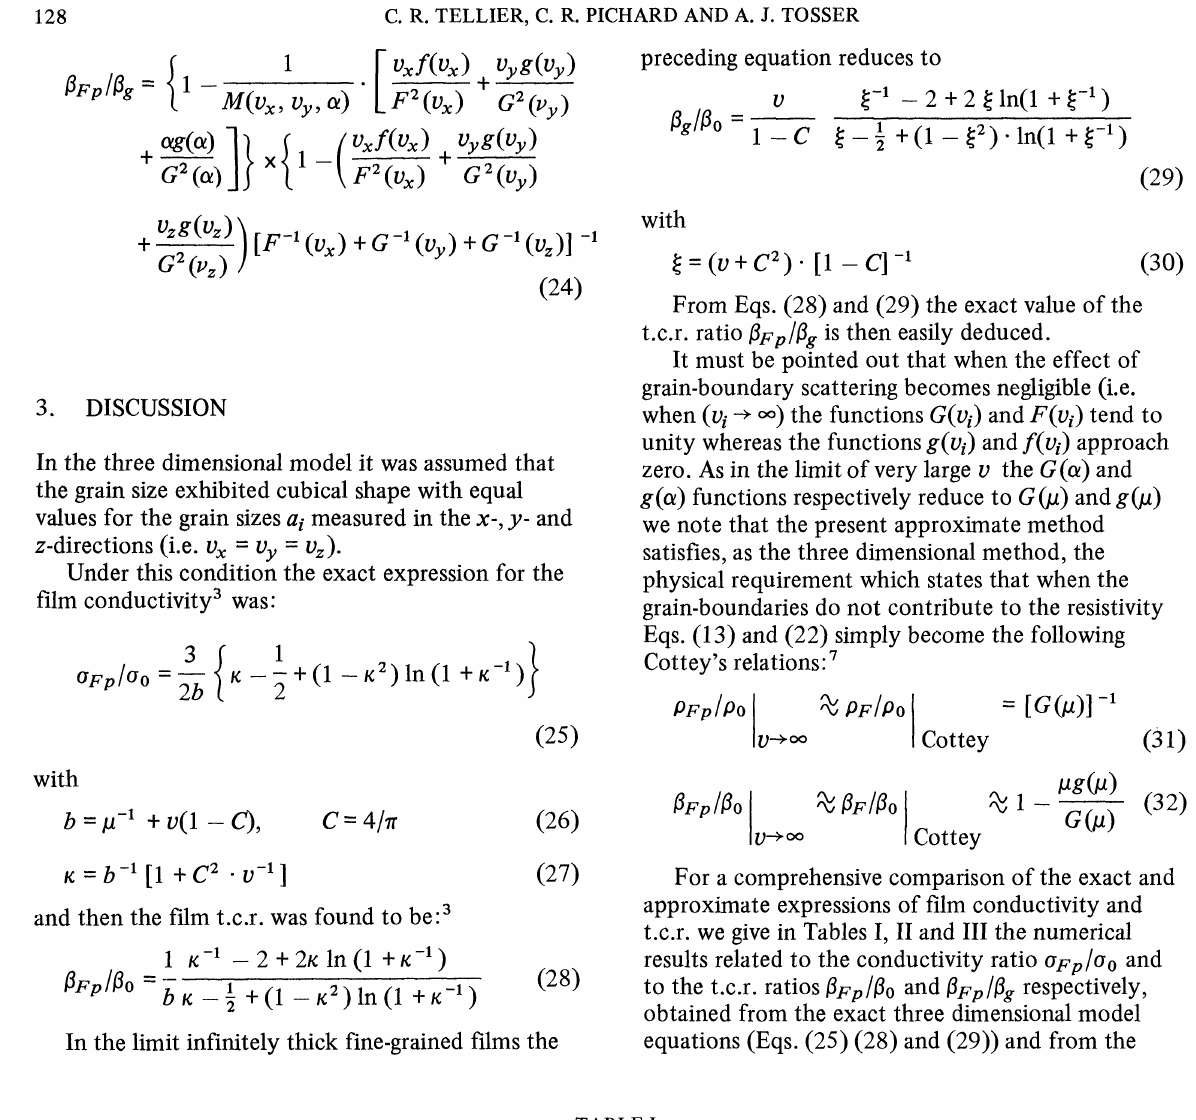
Comparison of the exact and approximate values of the conductivity ratio oFp/tr (as given by respective Eqs. (25) and (13)). 0=0.4 Exact